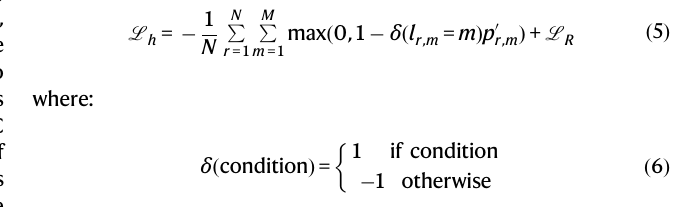
Fig. 7 | Practical implementation of the phase retrieval process. a ICs from a 4-way asymmetric pre-sample mask (experimental points and Gaussian fi ts are shown for each aperture, with different colour points corresponding to different apertures). b their fi t as a single 4-Gaussian function rather than through four separateGaussians.Theblackdotswitherrorbars(correspondingtoonestandard